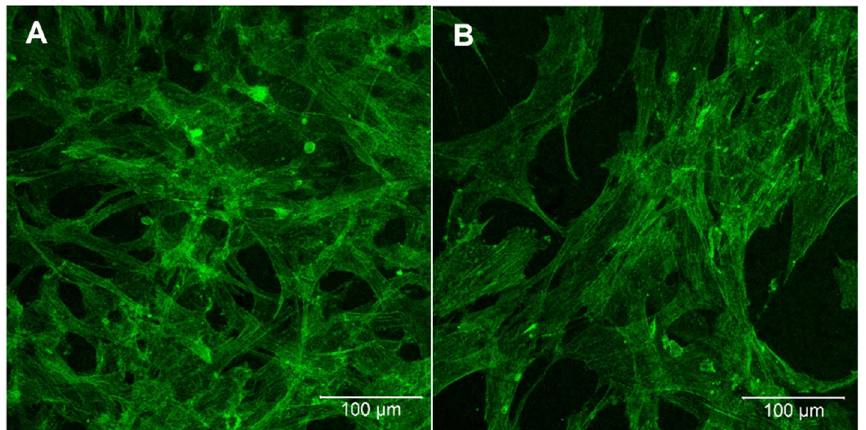
Figure 10. Confocal fluorescence images of bone marrow mesenchymal stem cells (BMSCs) cultured on ACM ( A , B ). ( B ) was coated with Poly-L-Lysin/Heparin to avoid any hemostatic reaction after blood contact. Green: Phalloidin488. Scale bars are 100 µm each.